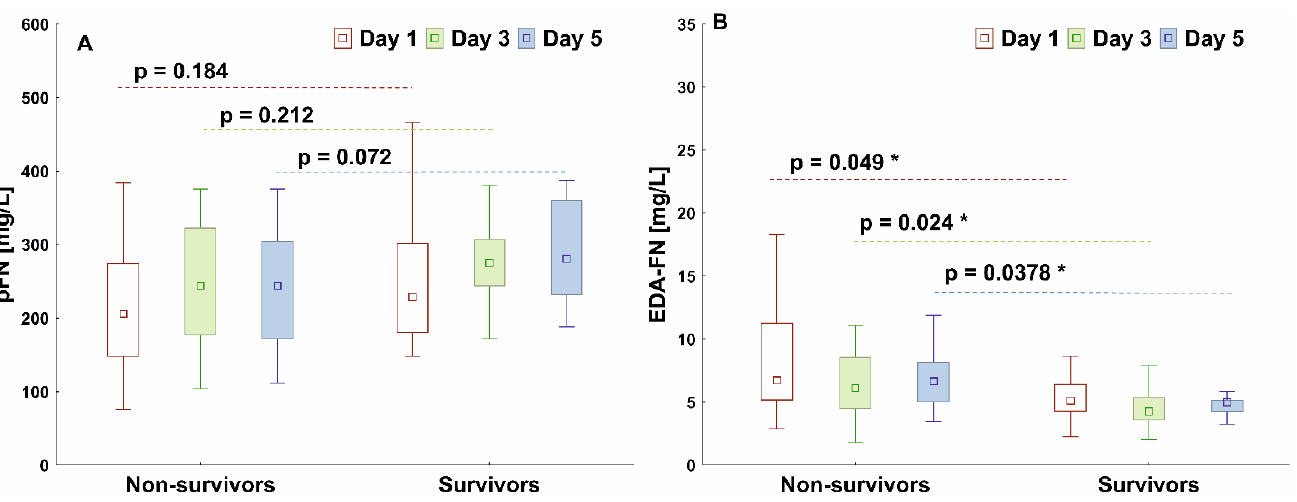
Figure 1. Graph comparing plasma fibronectin (pFN, ( A )) and cellular fibronectin (EDA-FN, ( B )) concentrations of COVID-19 Non-survivors and Survivors. The box plots represent the median values (midpoint) with interquartile range between the 25th and 75th percentiles (box); the whiskers represent the minimum and maximum values. * indicates p -value less than 0.05.